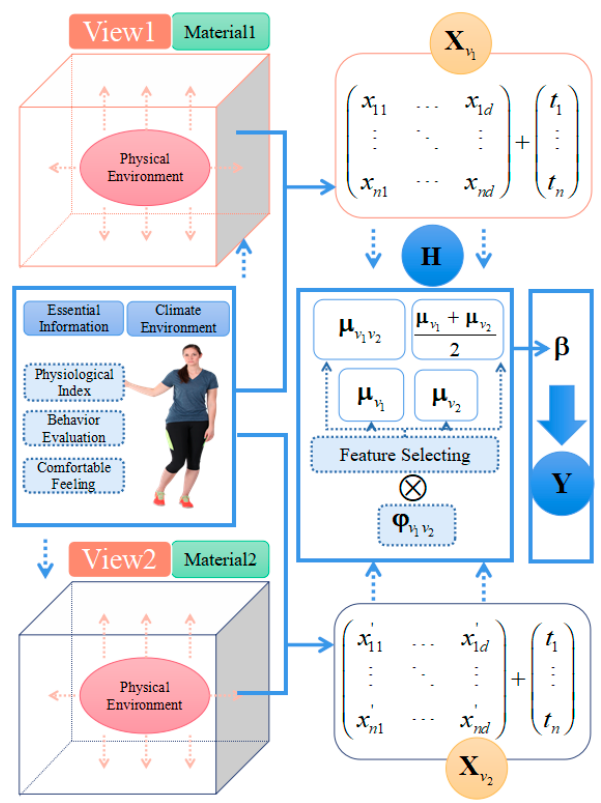
Figure 4. TMV-TSK-FC structure diagram.